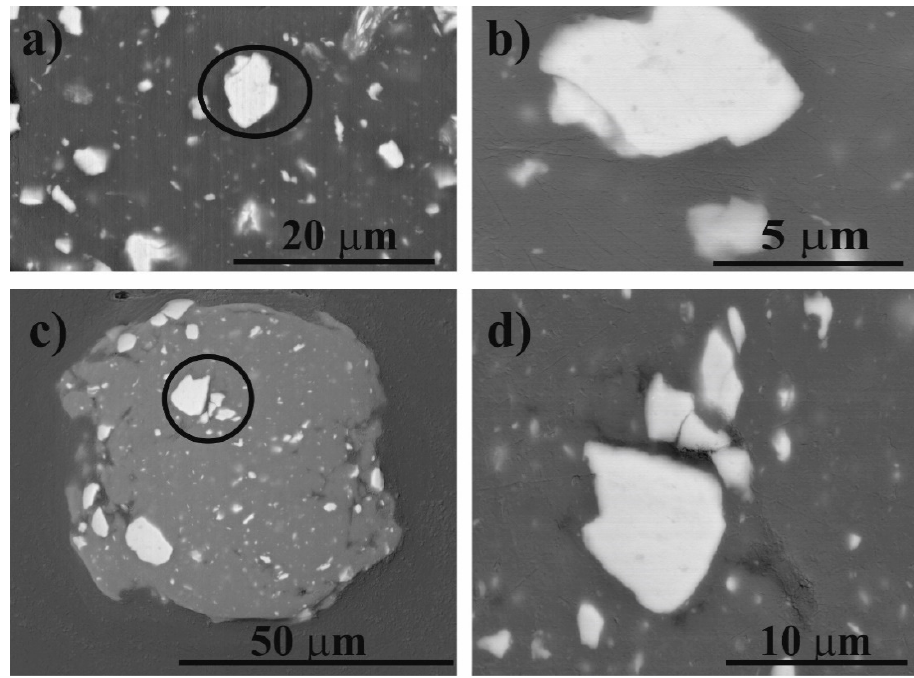
Figure 5. Cross-sectional backscattered SEM images of composite particles after 15 h ( a,b ) and 25 h ( c,d ) of milling time. Representative images showing particle/matrix interface (b,d).